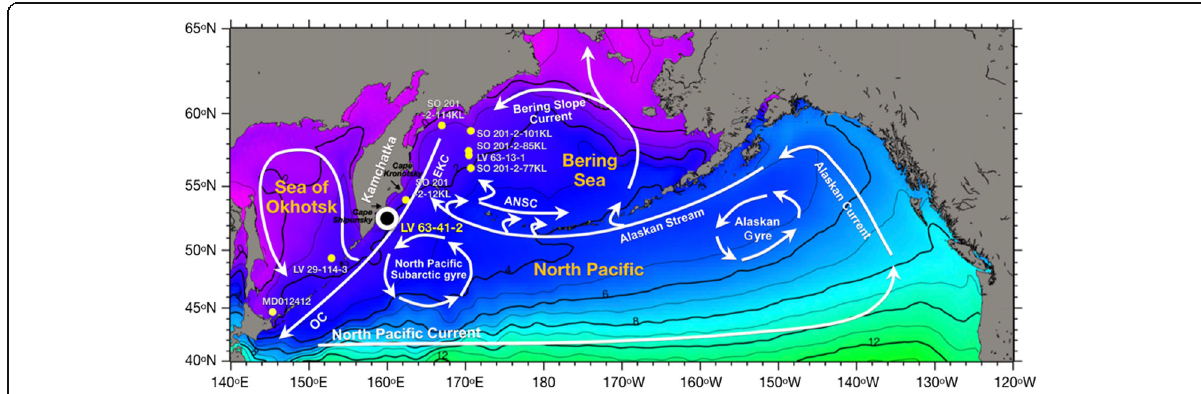
Fig. 1 Map of site locations of the subarctic NW Pacific used in this study. A series of sediment cores along the western blank of Bering Sea, off Kamchatka, and the Okhotsk Sea are used for extracting last glacial alkenone temperature variability of the subarctic NW Pacific. Modern annual mean SSTs in the Northern Pacific are shown with contours using oceanographic data from AVHRR for the 1982 – 2014 period (Banzon et al. 2016). Core LV 63-41-2 (52.56° N, 160.00° E; circled bullet symbol) was retrieved at a water depth of 1924 m from the continental slope off Kamchatka. Core sites of these published alkenone SST records (Seki et al. 2004b; Max et al. 2012) are marked by yellow circle symbols. Surface circulation patterns of the Northern Pacific are abbreviated as follows: EKC, East Kamchatka Current; OC, Oyashio Current; ANSC, Aleutian North Slope